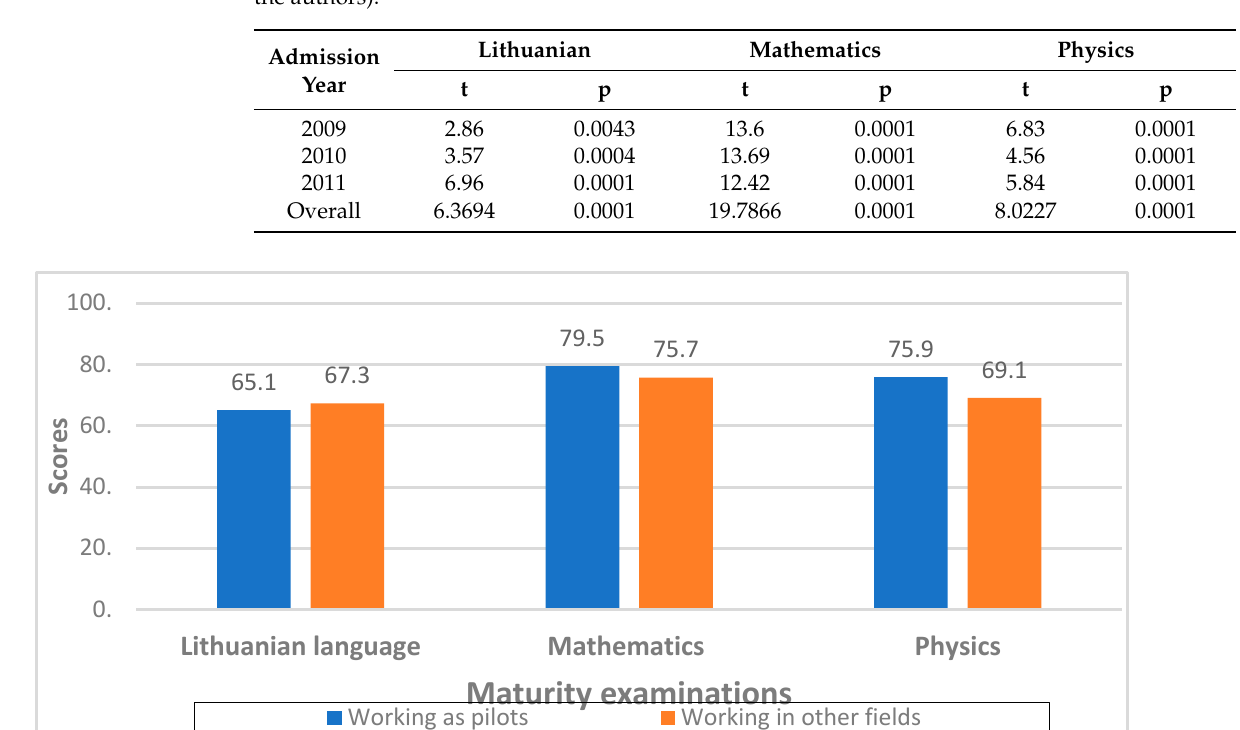
Figure 2. Comparison of examination scores of those working as pilots and those who chose other professions (source: created by the authors).